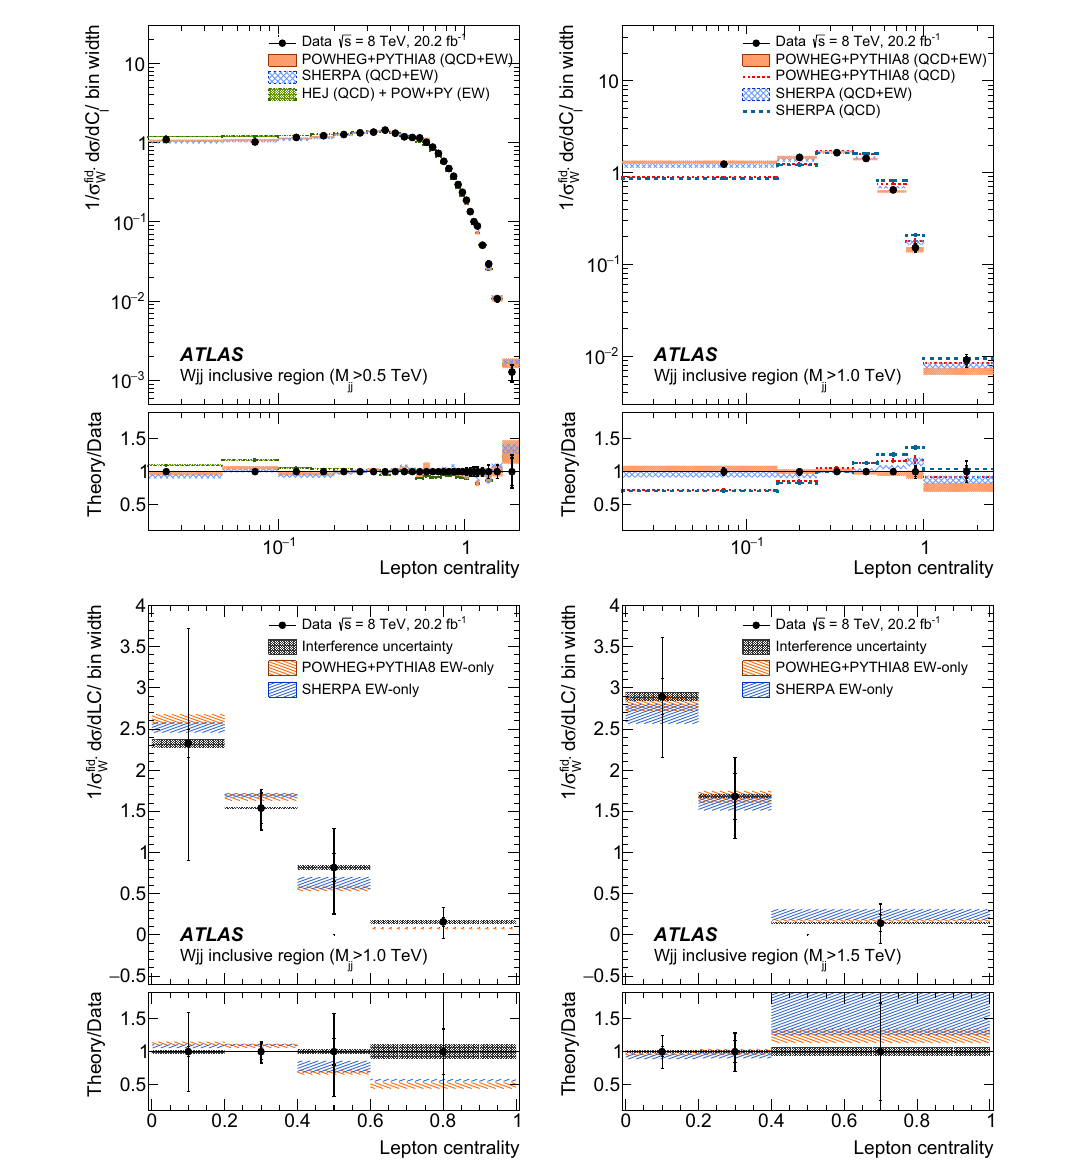
Fig. 23 Unfolded normalized differential QCD+EW W jj ( top ) and EW ( bottom ) production cross sections as a function of lepton cen- trality for the inclusive fiducial region with M jj > 0 . 5 TeV ( top left ), 1.0 TeV ( top right and bottom left ), and 1.5 TeV ( bottom right ). Both